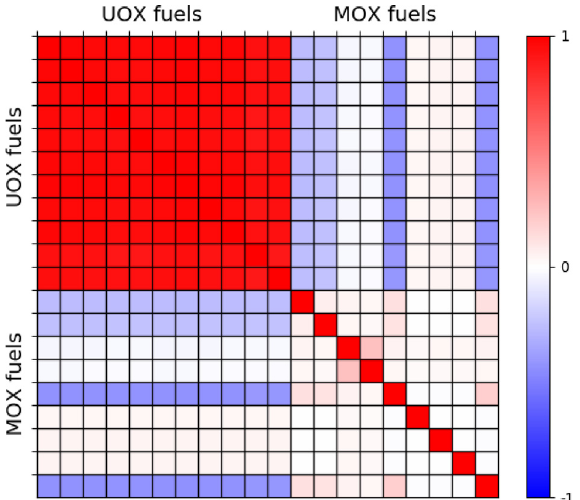
Fig. 1. Experimental correlation matrix obtained with the AGS code method, taking into account scheme-related